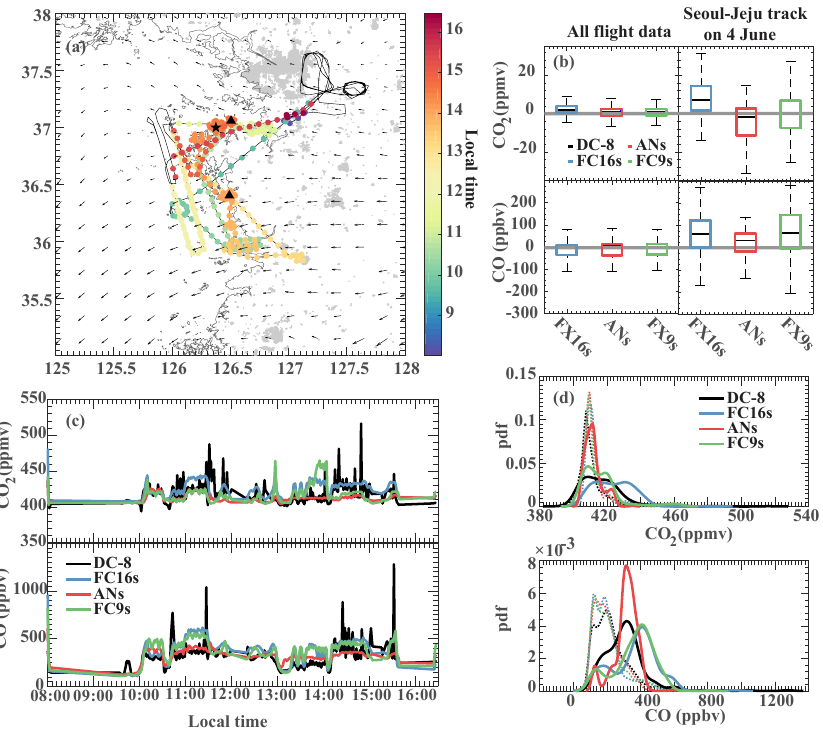
Figure 7. Case study for the flight on 4 June (UTC time). (a) Flight track of DC-8 aircraft in the Seoul–Jeju jetway group for this day. The Daesan chemical facility is marked as a black pentagram and two power plants are marked as black triangles. Arrows correspond to 950hPa wind field at 12:00LT. (b) Box plot of CAMS bias from all the DC-8 aircraft measurements during the campaign (left) and from measurements on 4 June in the Seoul–Jeju jetway group (right). Top row is for CO 2 and bottom row is for CO. (c) Time series of the DC-8 aircraft measurements and CAMS during the flight. (d) The pdfs of CO and CO 2 for measurements on 4 June of the Seoul–Jeju jetway group (solid) and for all groups